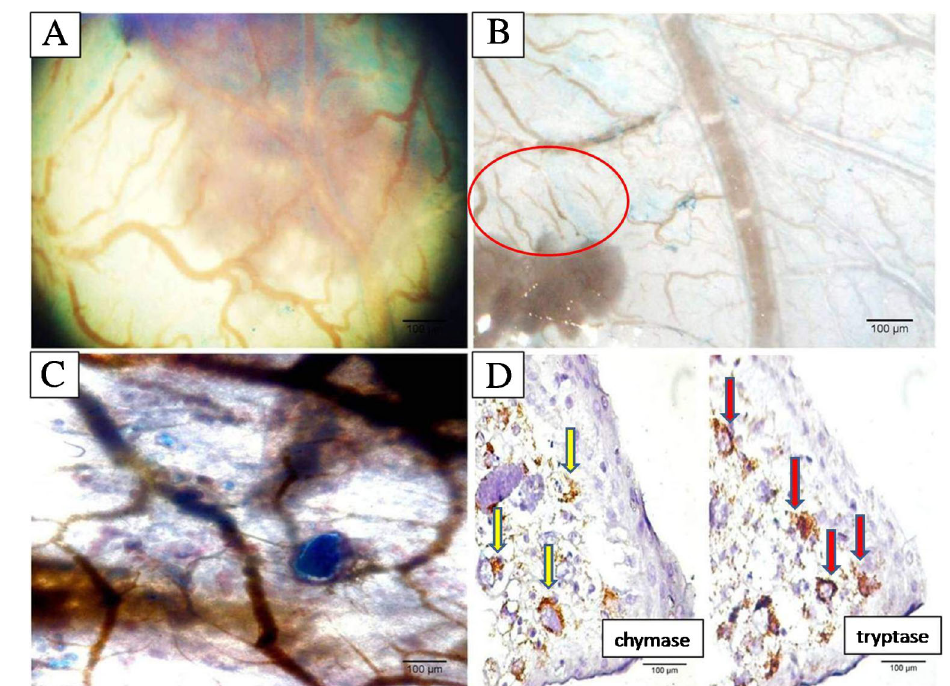
Figure 3. In ovo image of the mast cell tumor (mastocytoma) 7 days post-inoculation ( A ). Note the disorganized vascular network and the macroscopic appearance of tumor blood vessels. ‘‘Wheel spoke-like’’ arrangement of blood vessels around the tumor (red circle); peritumoral blood vessels showed higher density compared to the adjacent chorioallantoic membrane vascular network ( B ). Whole mount Alcian blue/safran staining of the chick embryo chorioallantoic membrane with a mastocytoma, before cutting ( C ). A mixture of both safran- and Alcian blue-positive mast cells composed the mast cell tumor, surrounded by a rich network of newly formed blood vessels. By immunohistochemistry, mastocytoma tumor cells were shown to be positive for both chymase ( D left, yellow arrows) and tryptase ( D right, red arrows) with a granular cytoplasmic